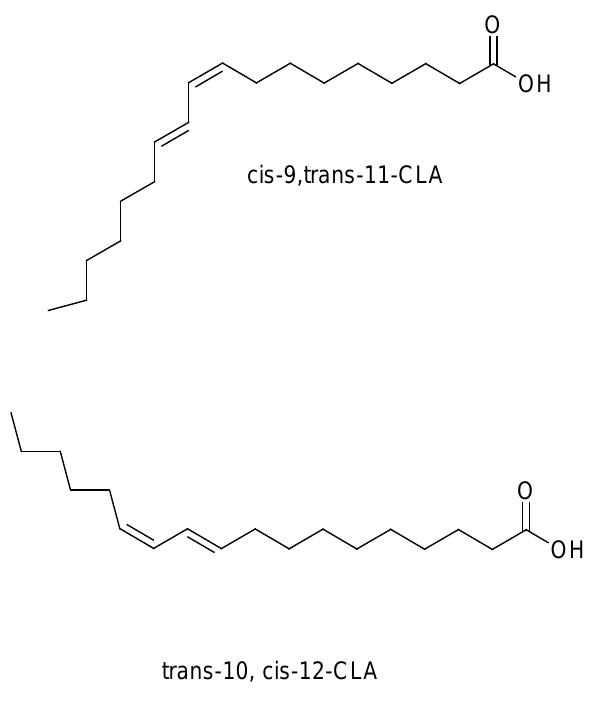
Figure 1. Structures of predominant conjugated linoleic acid